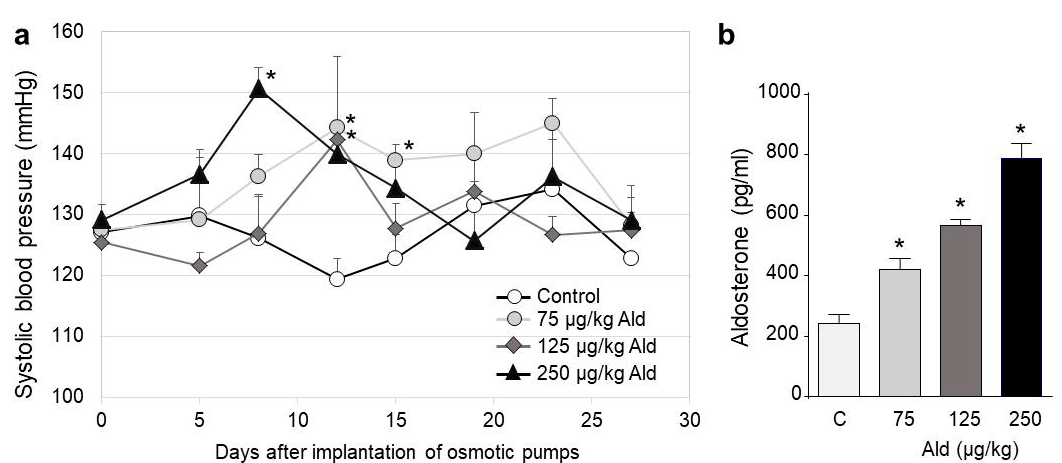
Figure 1. Blood pressure changes and aldosterone levels. ( a ) Development of systolic blood pressure in the control and aldosterone treatment groups. The blood pressure was measured at seven time points after acclimatization to the measurement procedure. The first time point represents the initial blood pressure before the implantation of osmotic pumps. The blood pressure was measured twice a week. ( b ) Aldosterone levels in the blood after 28 days of treatment. Ald: aldosterone. Data are shown as mean + SEM. * p ≤ 0.05 vs. C: control group. Table 1. Body weight, body weight ratios, and parameters of kidney function after 28 days of aldosterone infusion. Ald: aldosterone, NGAL: neutrophil gelatinase-associated lipocalin. Data are shown as